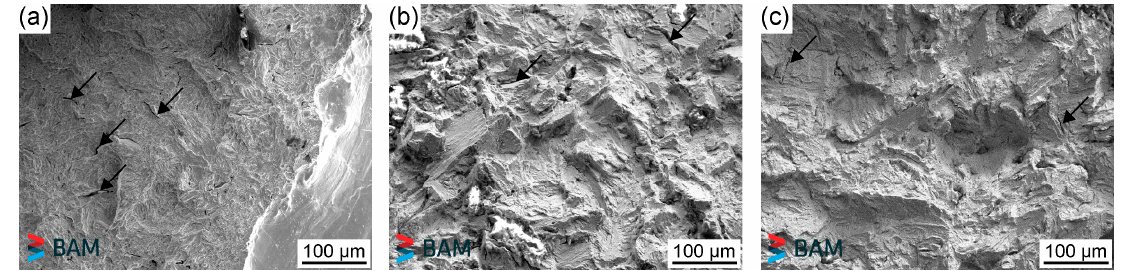
Figure 11. Fracture topography of cracks starting from the root notch: ( a ) Quasi-cleavage (QCl) at H D = 1.2 mL/100 g; ( b ) cleavage (Cl) at H D = 1.9 mL/100 g; ( c ) Cl at H D = 5.7 mL/100 g; arrows indicate secondary cracks.